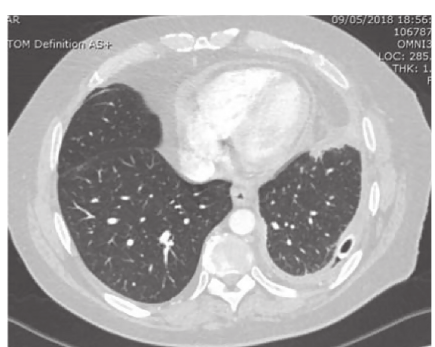
Figure 5: CT after readmission and